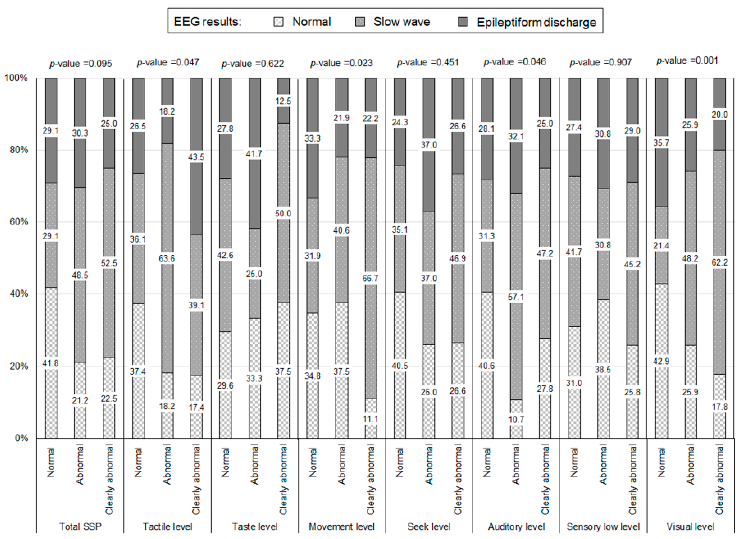
Figure 2. Electroencephalography (EEG) results according to the short sensory profile (SSP). p -Values were obtained from Fisher’s exact test.